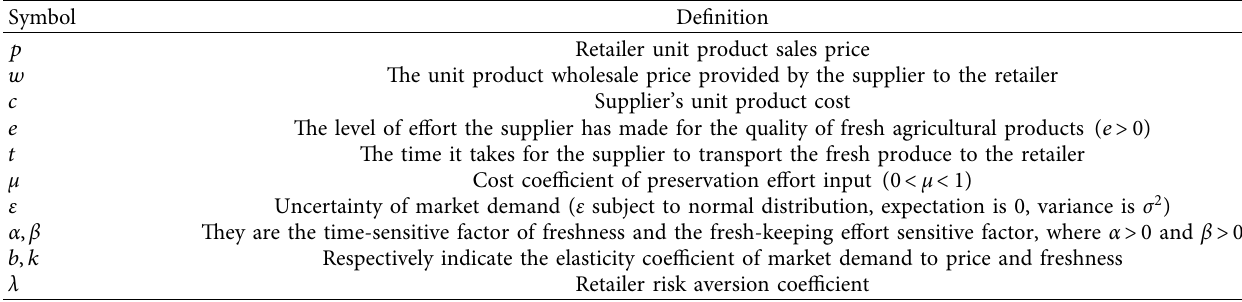
Table 1: The main symbols used in the